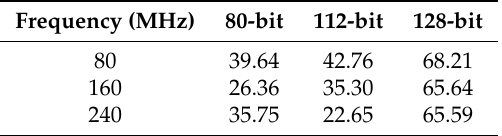
Figure 5. Energy consumption grouped by SoC frequency for the different tested ECDSA curves. Table 2. Energy consumption reduction (in percentage) of ECDSA in comparison to RSA.